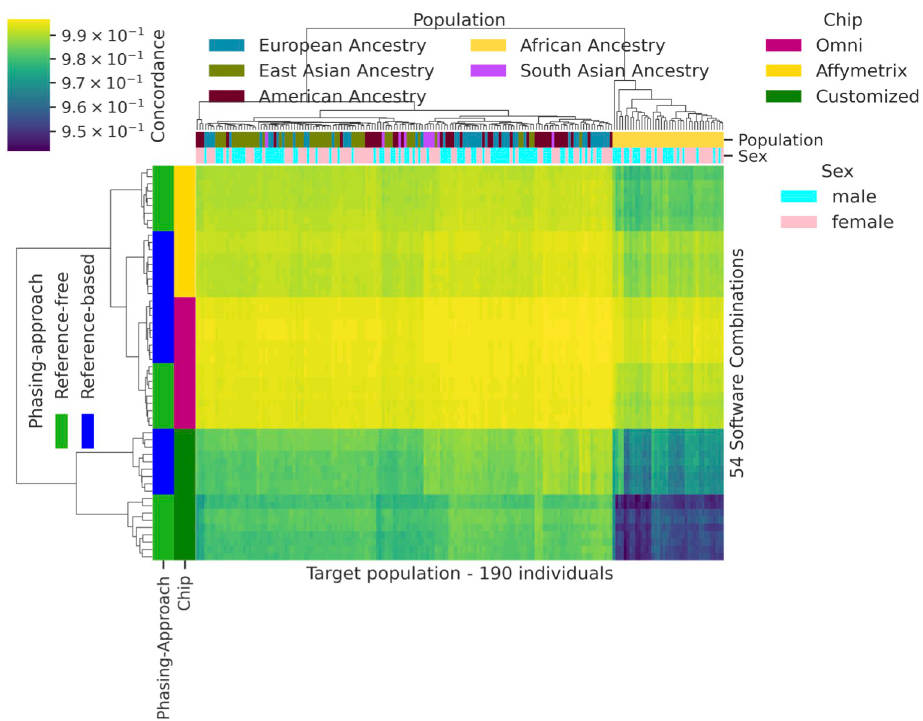
Fig 13. Cluster map of target population against 54 software-reference panel-dataset combinations. This figure depicts the concordance results for the reference-free and reference-based phasing approaches for each of these combinations. Higher density chips with a reference-based phasing approach and with populations without African ancestry obtained better results in terms of imputation accuracy measured by Concordance.